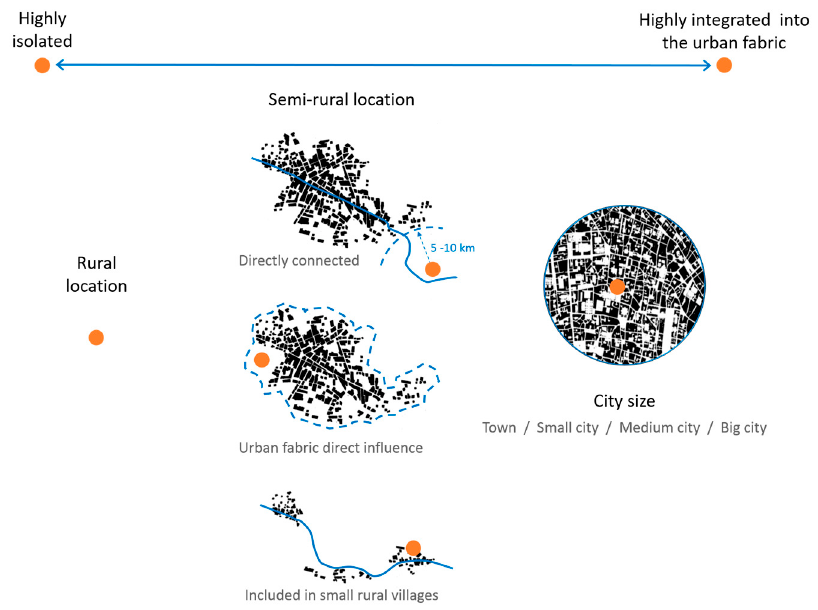
Figure 6. Guidelines for assets classification by criteria related to the grade of relation with human settlements.